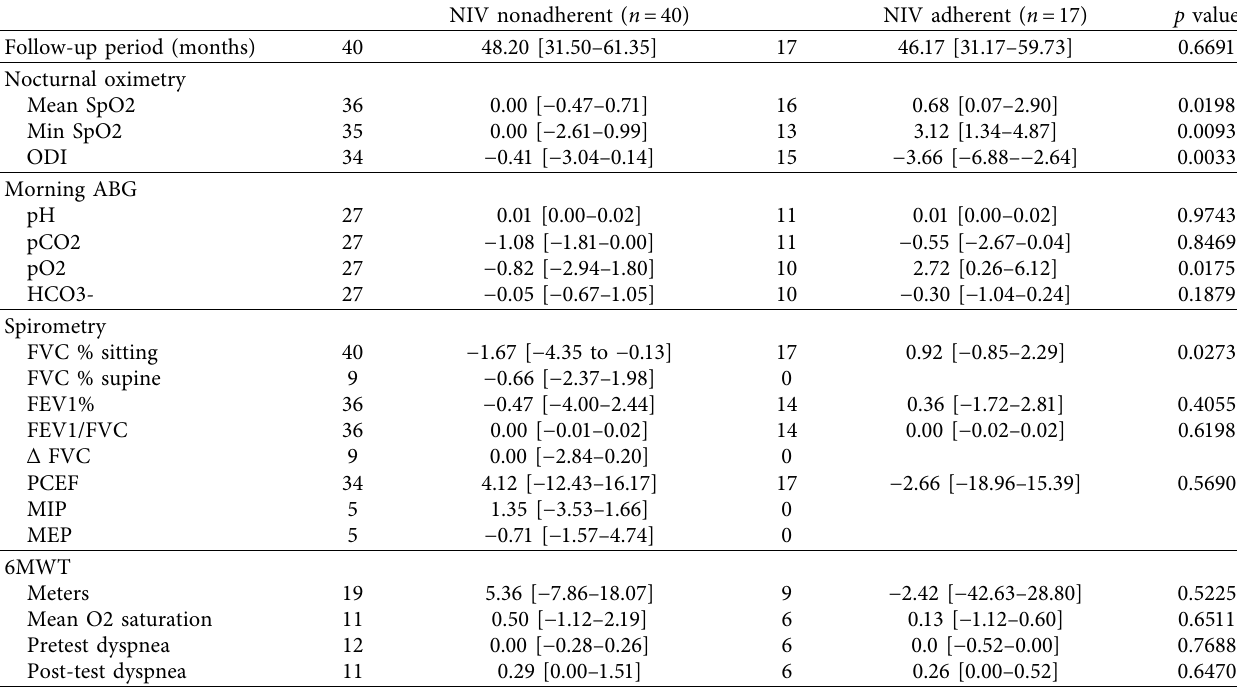
Table 7: Changes per year in the patients’ respiratory parameters based on their NIV